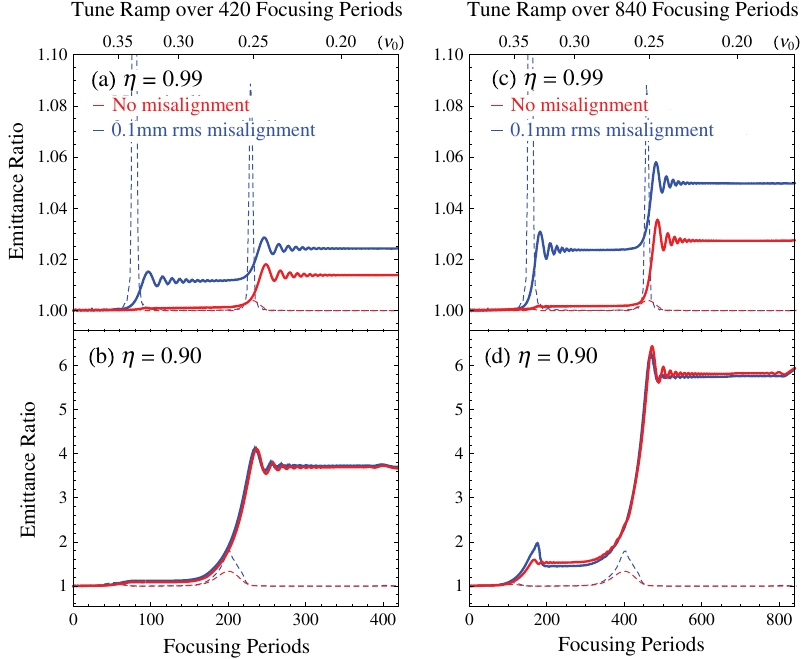
FIG. 6. Multiparticle simulation results with space-charge interactions. Input parameters here are similar to those adopted in Fig. 3, except that the collective Coulomb potential is now turned on. Two different tune depressions, i.e. (cid:3) ¼ 0 : 99 and 0.9, are chosen, for example. Red curves are obtained with no electrode misalignments while blue curves take into account rms misalignments of 0.1 mm. For reference, the corresponding stop-band distributions in Fig. 5 are added to each panel with broken